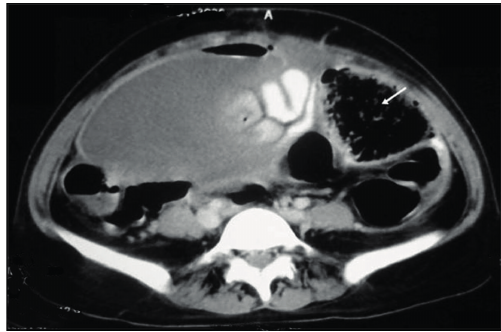
Figure 1: CT of abdomen showing a large fluid collection and another heterogeneous collection with air trapped within, on the left side [gossypiboma].